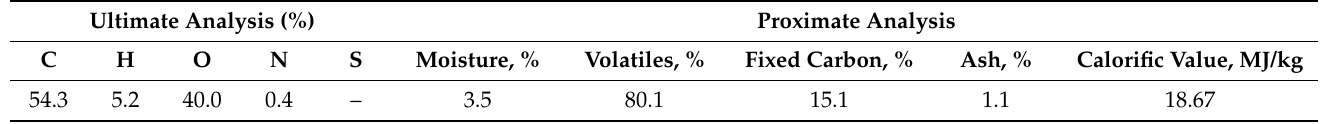
Table 1. Characteristics of